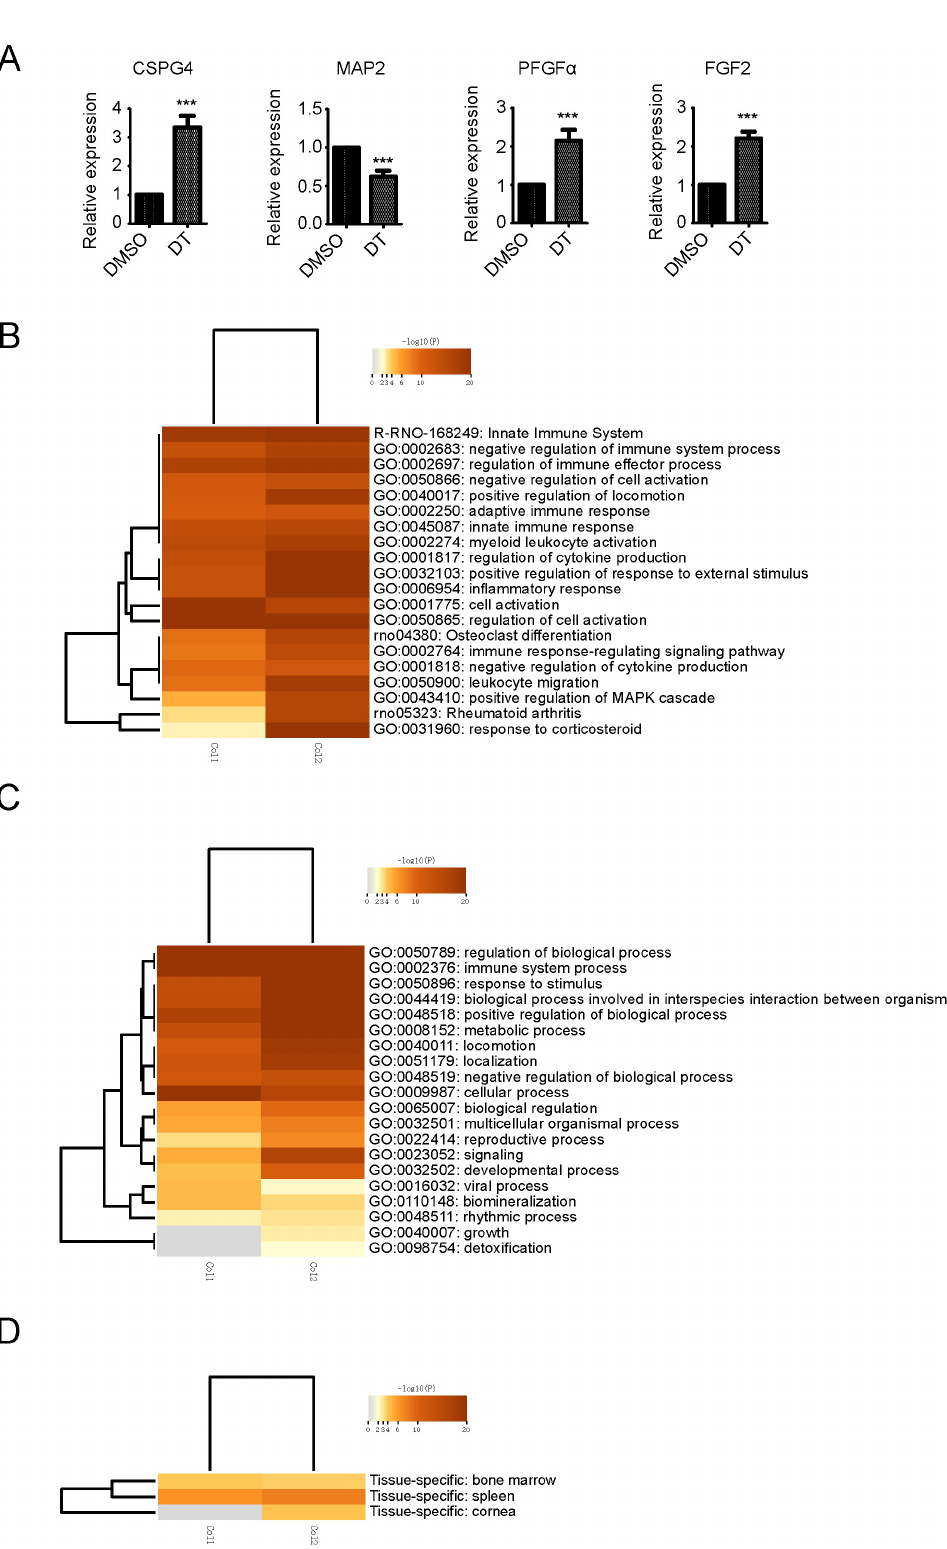
Figure 2. Transcriptome analysis of NSCs at day 3 of DT treatment and gene ontology terms enriched in up-regulated genes. Fold changes of the respective genes in NSCs treated with DMSO or DT. Comparing the expression obtained from mRNA-Seq, values of the reads were normalized with the average values of the housekeeping genes, ***, p < 0.001 by Student’s t -test ( A ). Heatmap of enriched terms across the top-level gene Ontology molecular function ( B ), biological processes ( C ) and cell type ( D ) among DMSO-NSCs and DT-NSCs, colored by p